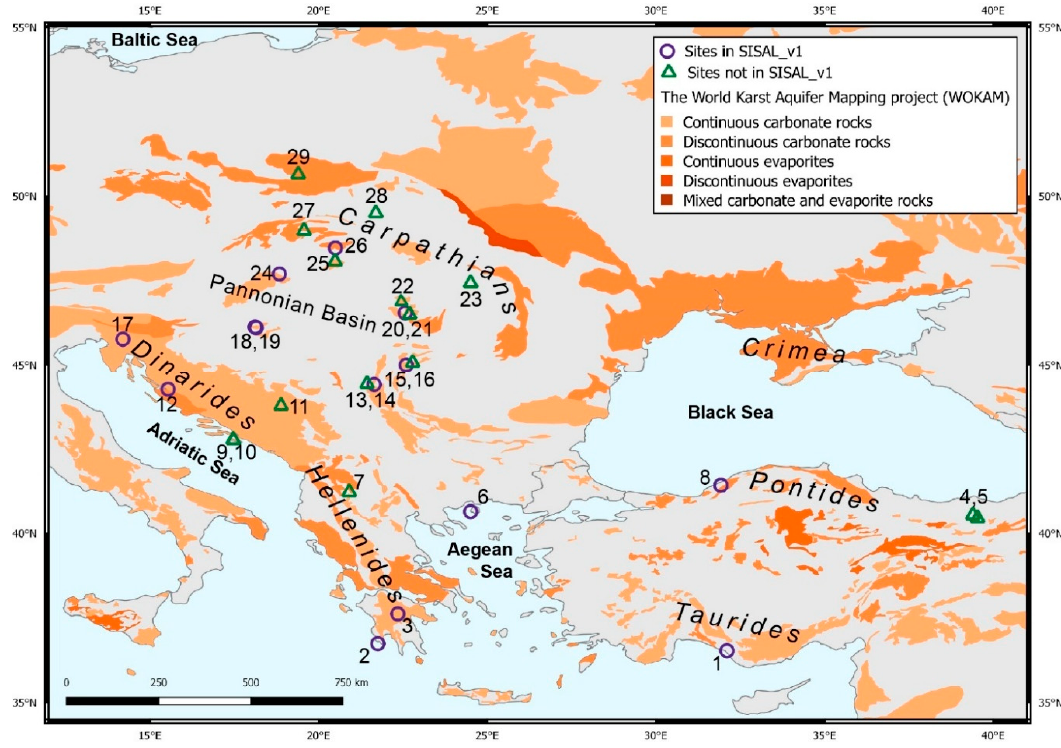
Figure 1. Map indicating the location of speleothem records from the Eastern part of Europe and Turkey. Purple circles show records in SISAL_v1 and green triangles note records not yet in the database. Background map show karst aquifers from the World Karst Aquifer Mapping Project [50]. Numbers next to the sites refer to the site names in Table 1.